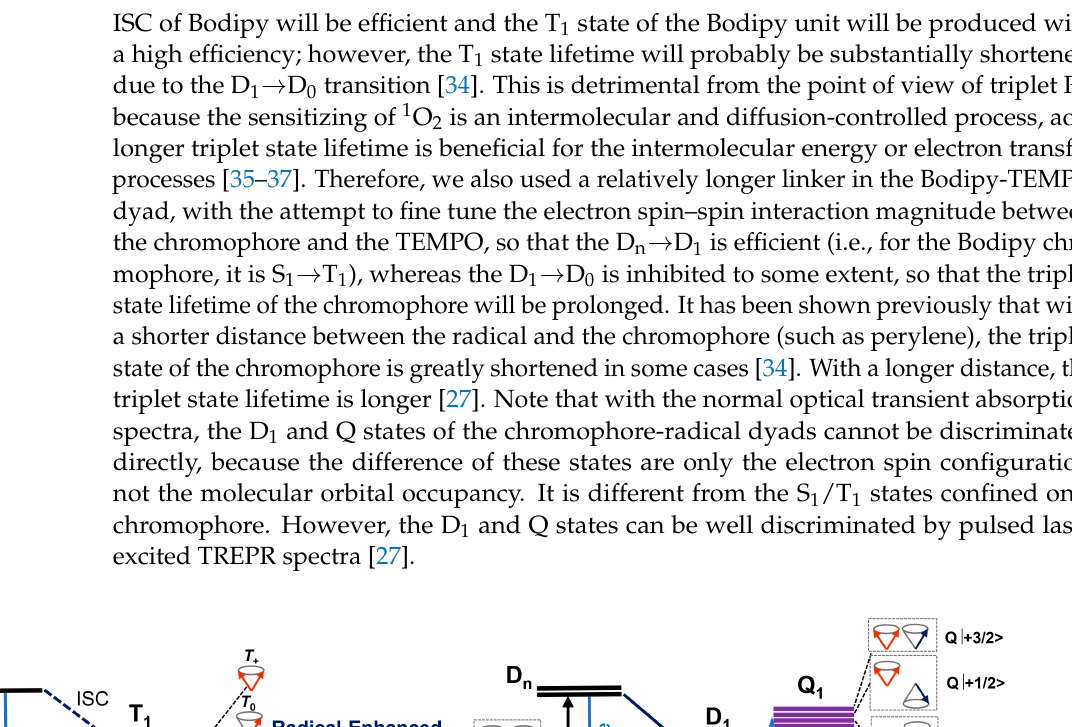
Figure 1. The mechanism of REISC in the chromophore-radical dyads. D 0 : doublet ground state, D n : excited doublet state, D 1 : the lowest excited doublet state, Q 1 : the lowest excited quartet state, 3 J : energy splitting ( J < 0), T + , T 0 , T − , D |+ 1/2 > , D | − 1/2 > , Q |+ 3/2 > , Q |+ 1/2 > , Q | − 1/2 > , Q | − 3/2 > : sublevel, B 0 : magnetic field. Reproduced with permission from reference [28], copyright 2021, American Chem- ical Society.